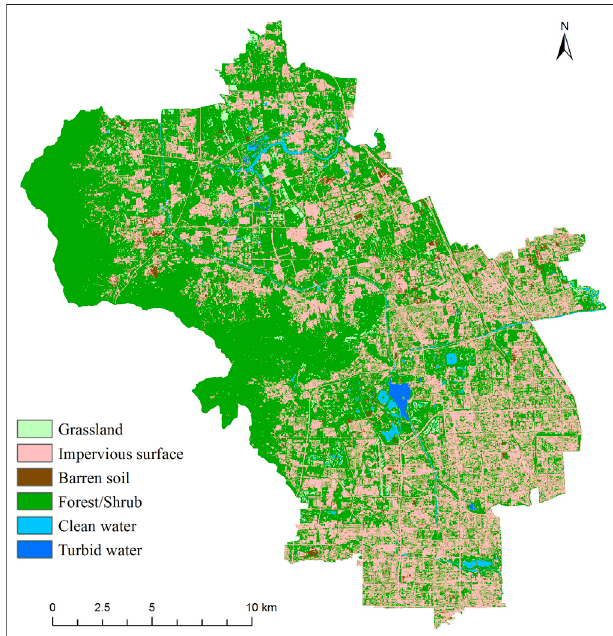
FIGURE 3 | Land cover classi fi cation of Haidian District,